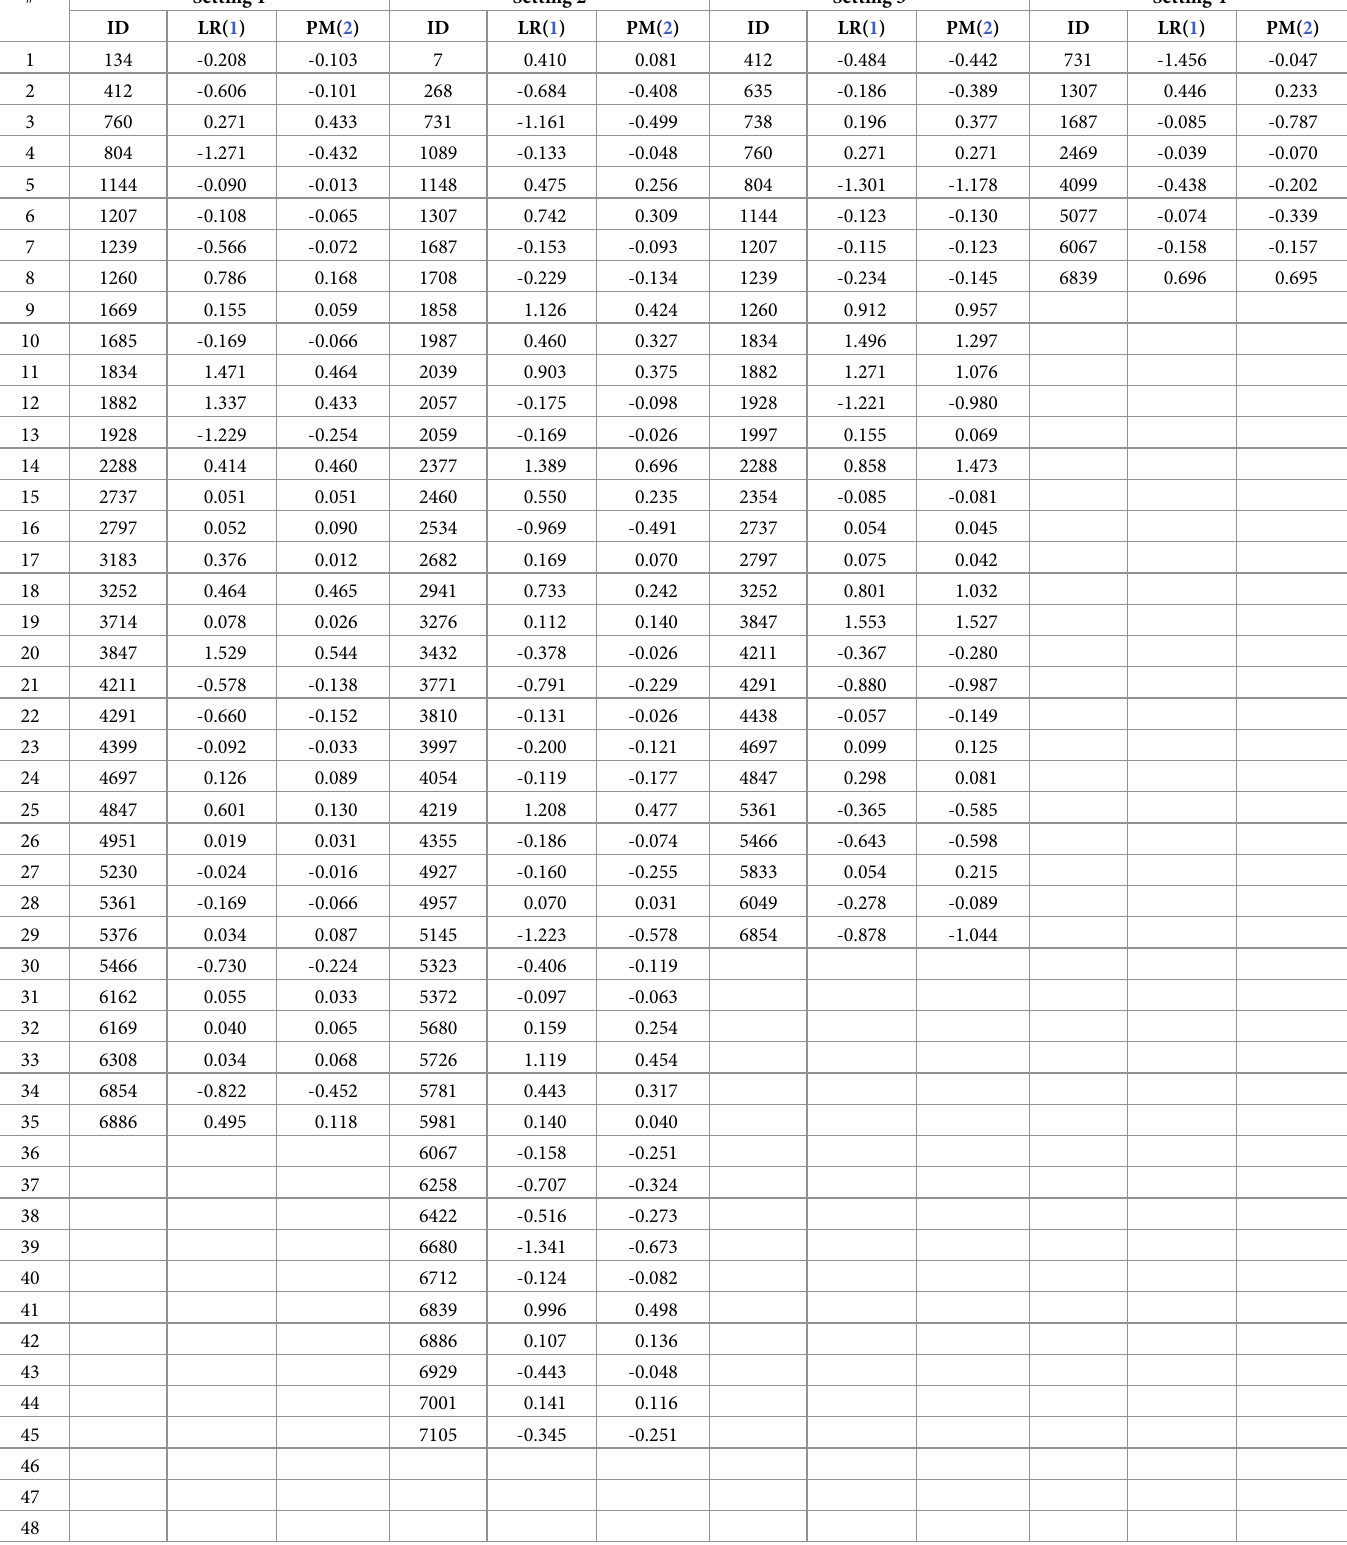
Table 3. Summary of common genes based on the logistic regression model and the probit